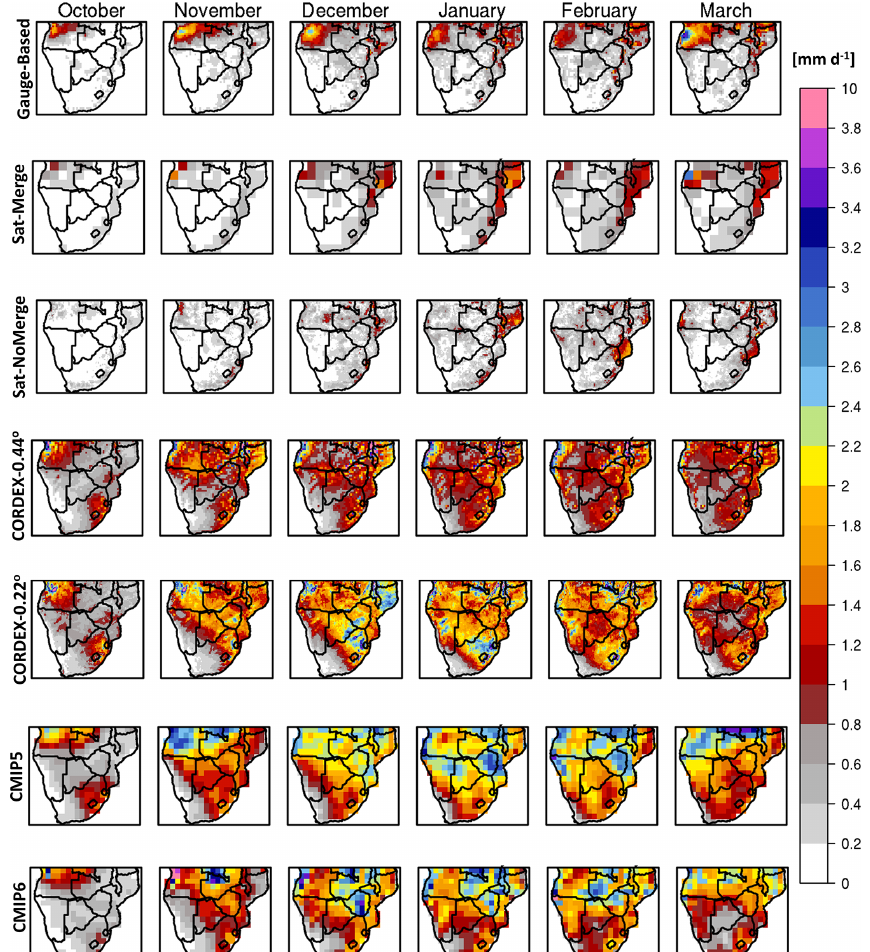
Figure 2. Standard deviation of monthly precipitation [mmd − 1 ] during the period 1986–2005. Rows indicate the ensemble means analyzed. From top to bottom – Gauge-based: ensemble mean of datasets that were produced by employing spatial interpolation methods using rain gauges/station data; Sat-Merge: ensemble mean of all satellite products that merge with rain gauges/station data; Sat-NoMerge: ensemble mean of satellite products that do not merge with rain gauges/station data; CORDEX-0.44 ◦ : ensemble mean of regional climate model simulations performed in the context of the Coordinated Regional Climate Downscaling Experiment – Africa domain with a spatial resolution equal to 0.44 ◦ × 0.44 ◦ ; CORDEX-0.22 ◦ : CORDEX-Africa simulations with a spatial resolution equal to 0.22 ◦ × 0.22 ◦ ; CMIP5: ensemble mean of general circulation models participating in the Coupled Model Intercomparison Project Phase 5 (CMIP5) that were used as forcing in the CORDEX-Africa simulations; CMIP6: ensemble mean of general circulation models participating in the Coupled Model Intercomparison Project Phase